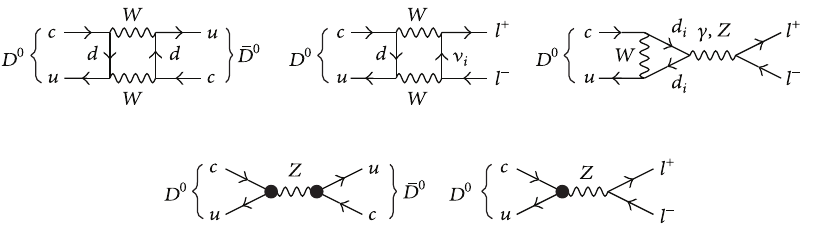
Figure 2: Feynman diagrams for 𝐷 0 mixing and decay at loop level in the SM (first row) and at tree level with the presence of VLQs (second